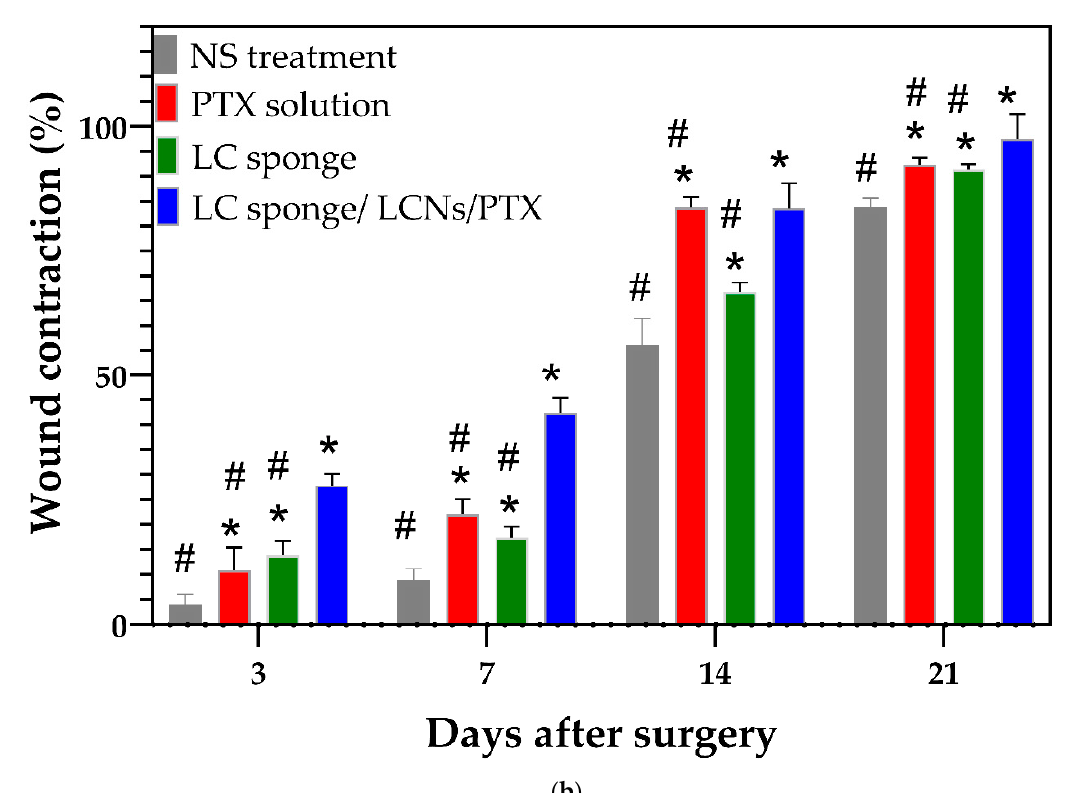
Figure 6. Wound healing process of treated rats with normal saline, free PTX, LC sponge, and LC sponge containing LCNs/PTX, ( a ) Photographical images of wound contraction on different days of control and treated animals. ( b ) Representation of percentage wound contraction of control and treated wounds. Values are expressed as mean ± SD for twenty-four animals. *: indicates the significant differences with NS treatment group and #: indicates the significant differences with LC sponge containing LCNs/PTX group.